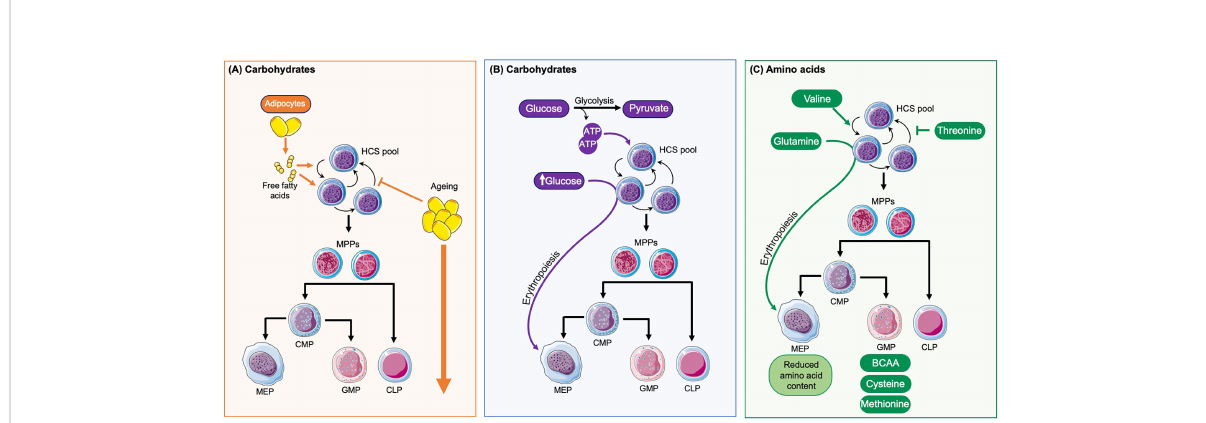
FIGURE 2 How diet in fl uences haematopoesis. (A) Adipocytes are found in close proximity to HSCs and provide free fatty acids, which play a role in HSC maintenance and self-renewal and are an important energy source for HSC expansion. With ageing there is an accumulation of adipocytes which disrupt the normal regulation of haematopoiesis and overall drives the expansion of HSCs and progenitor cells. (B) In the steady state HSCs primarily rely on glycolysis for the production of ATP and normal haematopoietic maintenance. High levels of glucose also enhance HSC commitment towards the erythroid lineage. (C) The amino acid valine has been shown to be vital for HSC maintenance and self-renewal whilst threonine can disrupt this. Glutamine promotes erythropoiesis. The amino acids cell content varies between different progenitors with MEPs having reduced levels and GMPs the highest levels, particularly of branched amino acids (BRAA), cysteine and